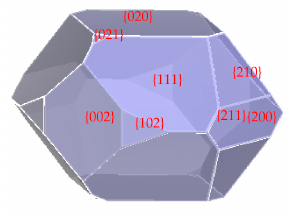
Figure 1. The morphology of RDX crystal grown in vacuum. Table 1. The face characteristic data of RDX growing in vacuum